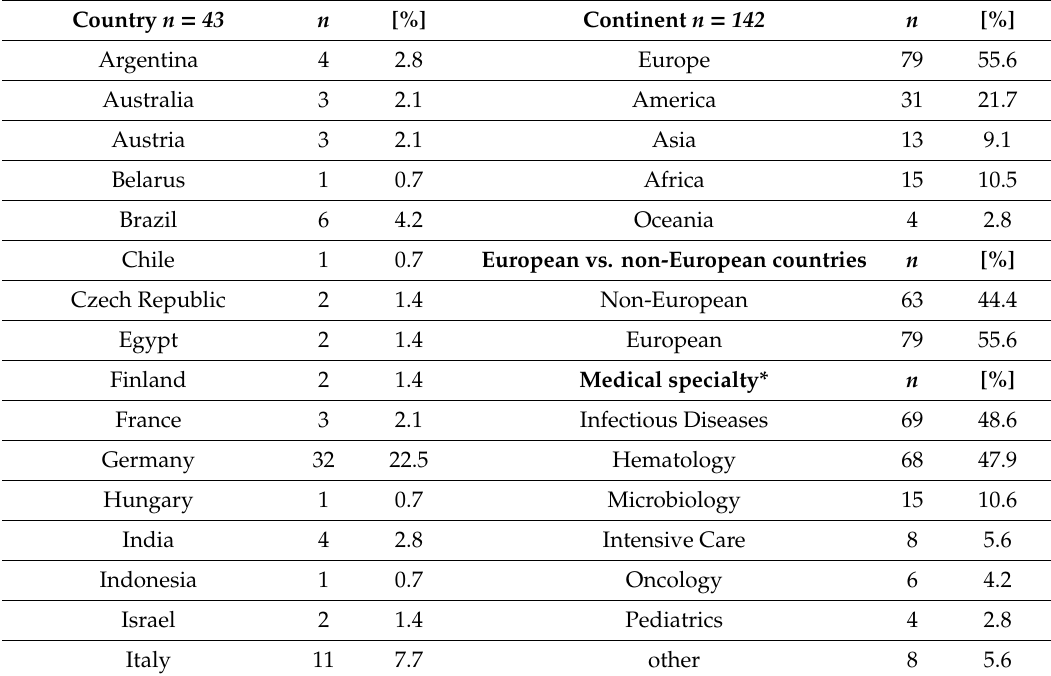
Figure 1. Geographic Distribution of Survey Participants. Table 1. Participant